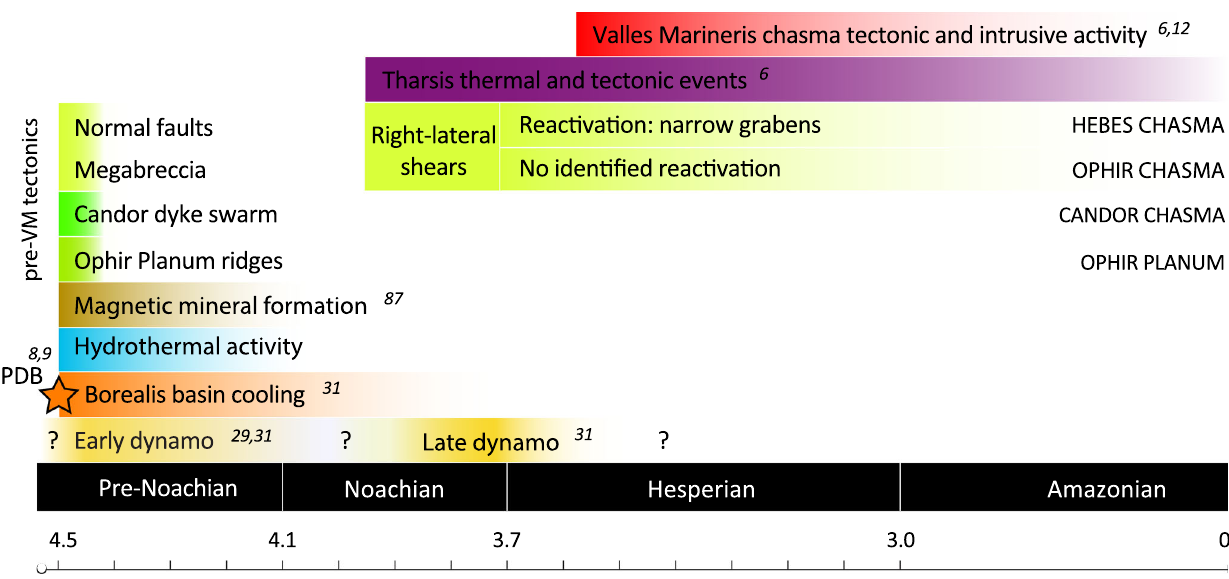
Fig. 6 Chronology of geodynamic and tectonic events in the Valles Marineris region. Large-scale post-Noachian tectonic activity at the shear zones is mainly restricted to the formation of narrow grabens, but as major crustal discontinuities, shear zone structures may have been occasionally active seismically until now. Numbers refer to the cited